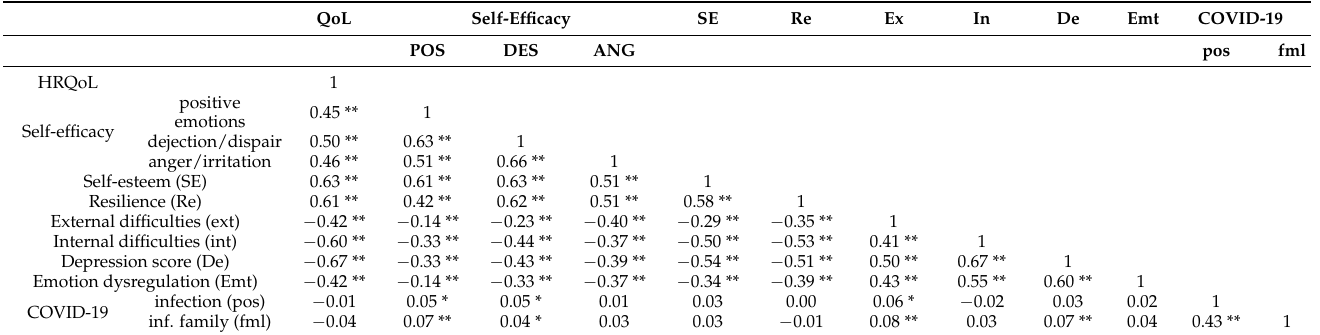
Table 3. Intercorrelation matrix of the manifest variables included in the